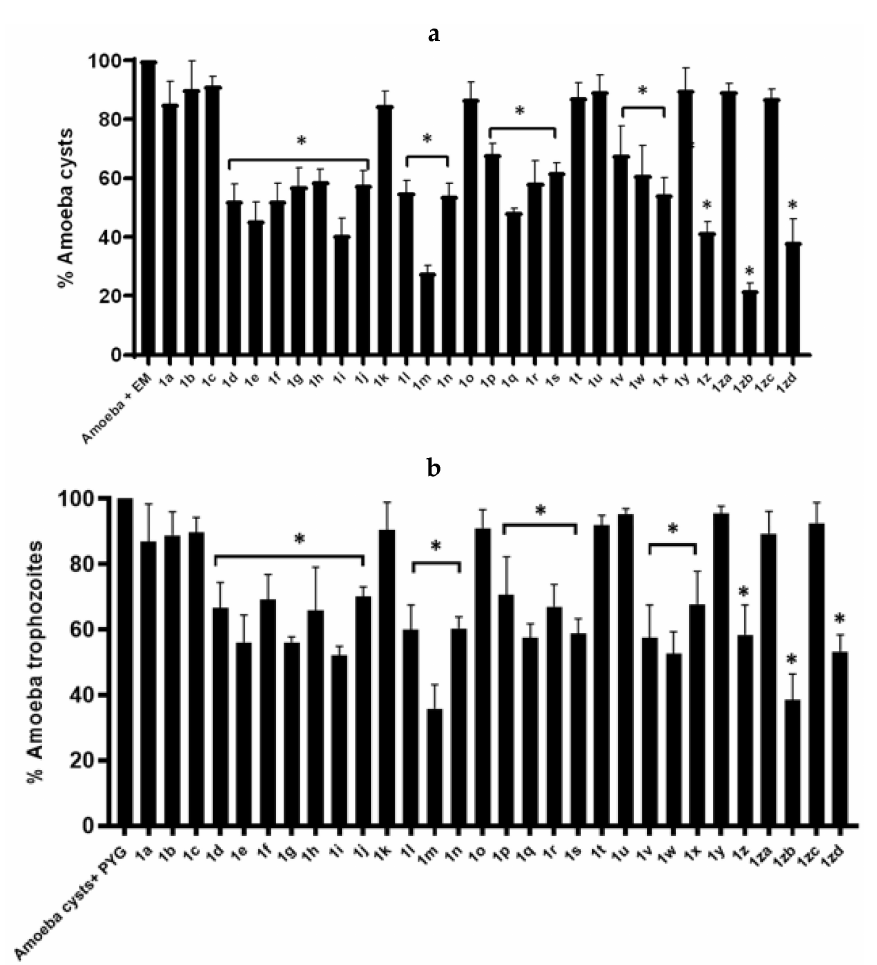
Figure 3. Compounds significantly inhibited both the encystation and excystation in A. castellanii . The results revealed that compounds and their analogues repressed the encystment as well excyst- ment process when compared to the negative control. ( a ) Represents the encystation process while ( b ) Denotes the excystation effects. The data is presented as the mean ± standard error. p values were calculated using a two-sample t -test with a two-tailed distribution and (*) denotes that p ≤